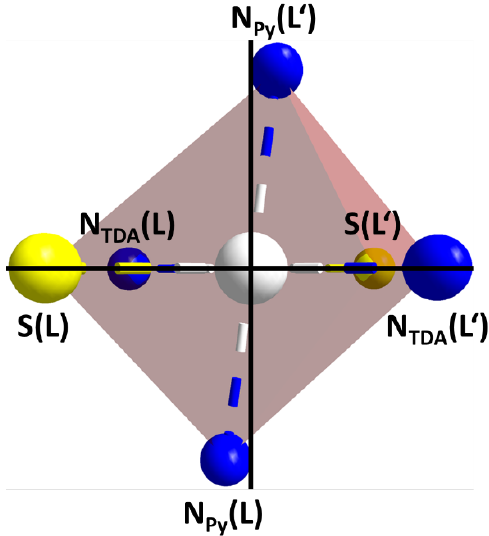
Figure 3. Coordination octahedron for the metal(II) ion of C1 and C2 .